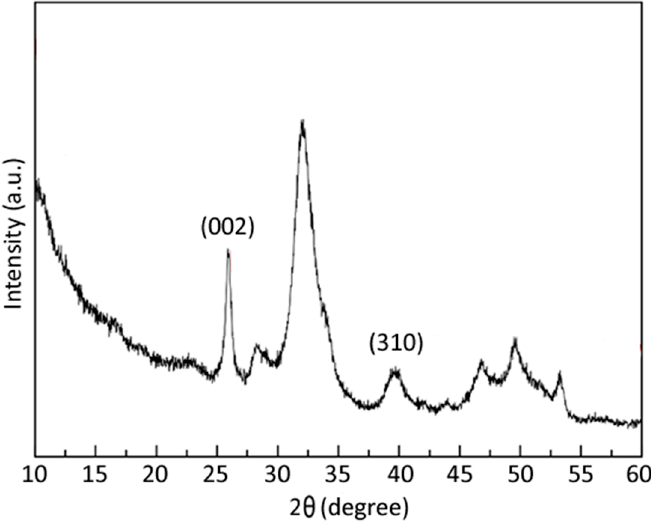
Figure 1. Powder X-ray diffraction (PXRD) pattern of nanoparticles ( n HA) in the 2 θ range from 10° to 60°.